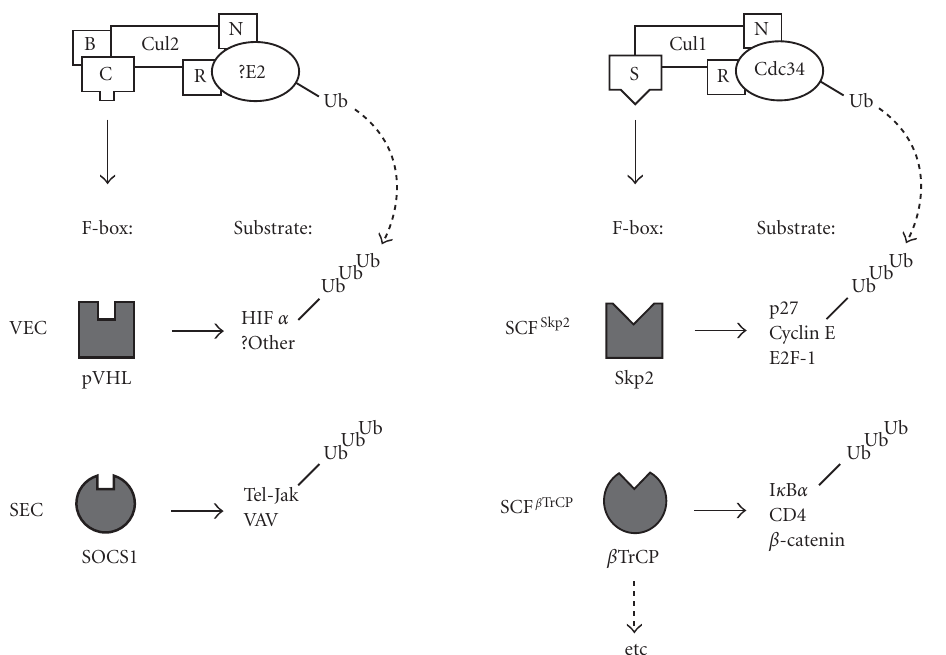
Figure 1. Comparison between the modular SCF and VEC complexes. SCF complex is composed of Skp1, Cdc53, Rbx1, and an F-box protein. Substrate specificity is conferred by the F-box protein. For example, SCF Skp2 in concert with E2 ubiquitin-conjugating enzyme Cdc34 selectively targets the phospho- rylated p27, as well as E2F-1 and Cyclin E, for ubiquitination. VEC complex is composed of Skp1-like elongin C, Cdc53 homologue Cul2, common Rbx1, ubiquitin-like elongin B and an F-box protein pVHL. The SCF-like VEC complex in concert with a cognate E2 targets prolyl hydroxylated HIF α subunits for ubiquitylation. NEDD8 conjugation to Cul1 or Cul2 enhances the E3 activity of both SCF and VEC complexes. Replacement of the F-box protein pVHL with SOCS1 forms SEC that specifically targets VAV or Tel-Jak. B represents elongin B; C represents elongin C; S represents Skp1; R represents Rbx1; N represents